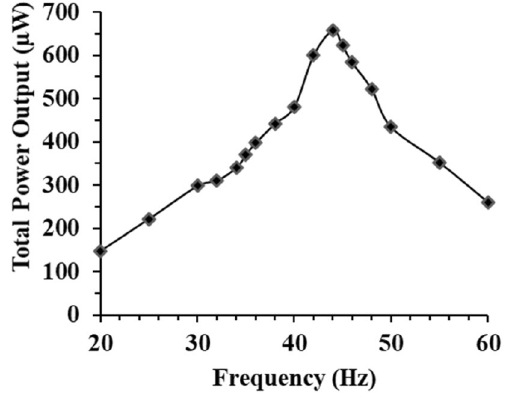
Figure 12. Total power output of MT-HPTEH against frequency load of 180 kΩ.